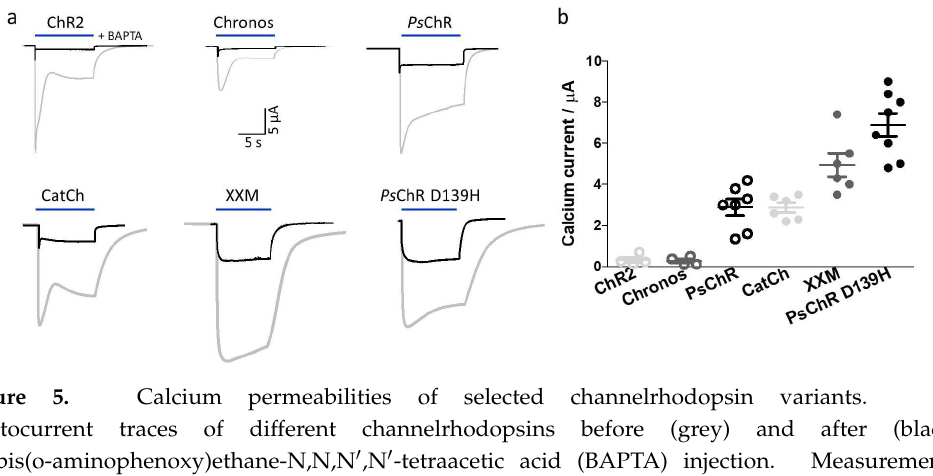
Figure 5. Calcium permeabilities of selected channelrhodopsin variants. ( a ) Photocurrent traces of different channelrhodopsins before (grey) and after (black) 1,2-bis(o-aminophenoxy)ethane-N,N,N′,N′-tetraacetic acid (BAPTA) injection. Measurements were done in 80 mM CaCl 2 pH 9.0 at −100mV. Blue bars indicate light illumination. ( b ) Comparison of calcium permeability of ChR2 (light grey), Chronos (dark grey), Ps ChR (black), CatCh (light grey), XXM (dark grey), and Ps ChR D139H (black). All data points were plotted in the figure and mean ± SEM was indicated.